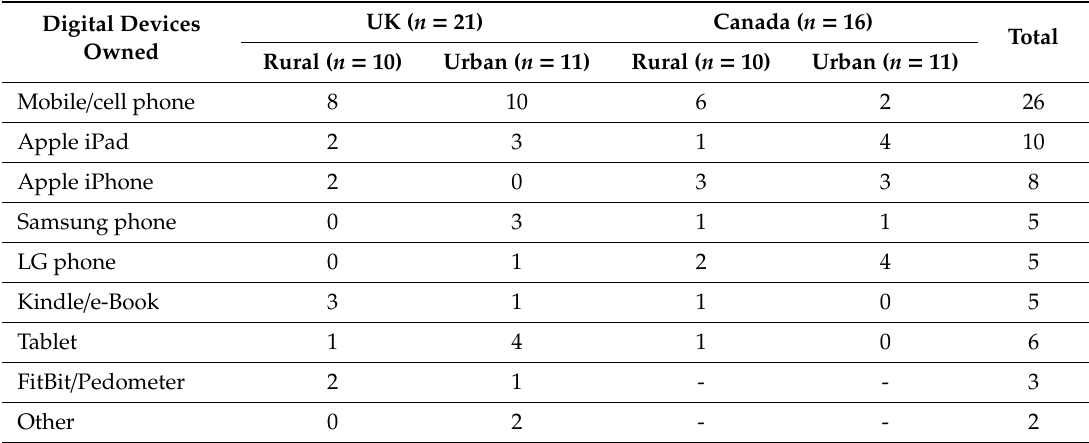
Table 6. Digital devices owned ( n = 37) by country (UK and Canada) and location (rural and urban) Digital Devices